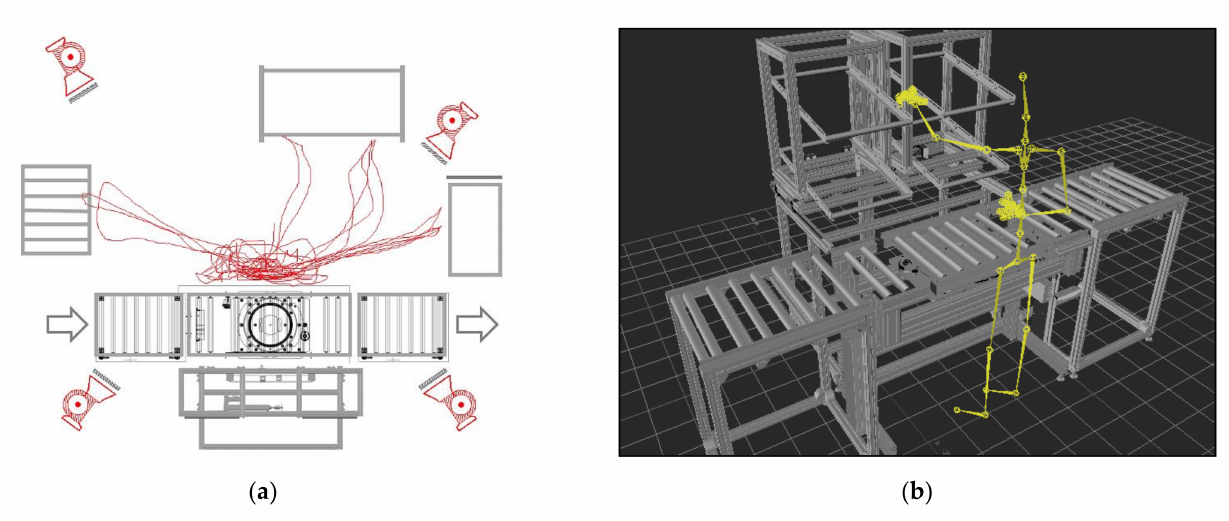
Figure 5. Motion analysis system: ( a ) architecture of the system with cameras positioned; ( b ) 3D digital environment with the human